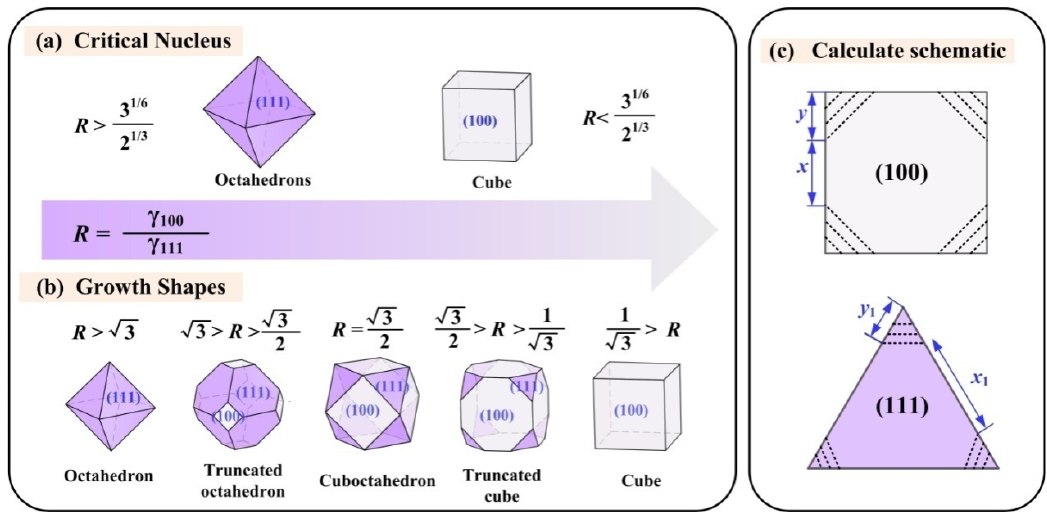
Figure 5. The surface energy ratio limits for observing the ( a ) critical nucleus and ( b ) growth shapes